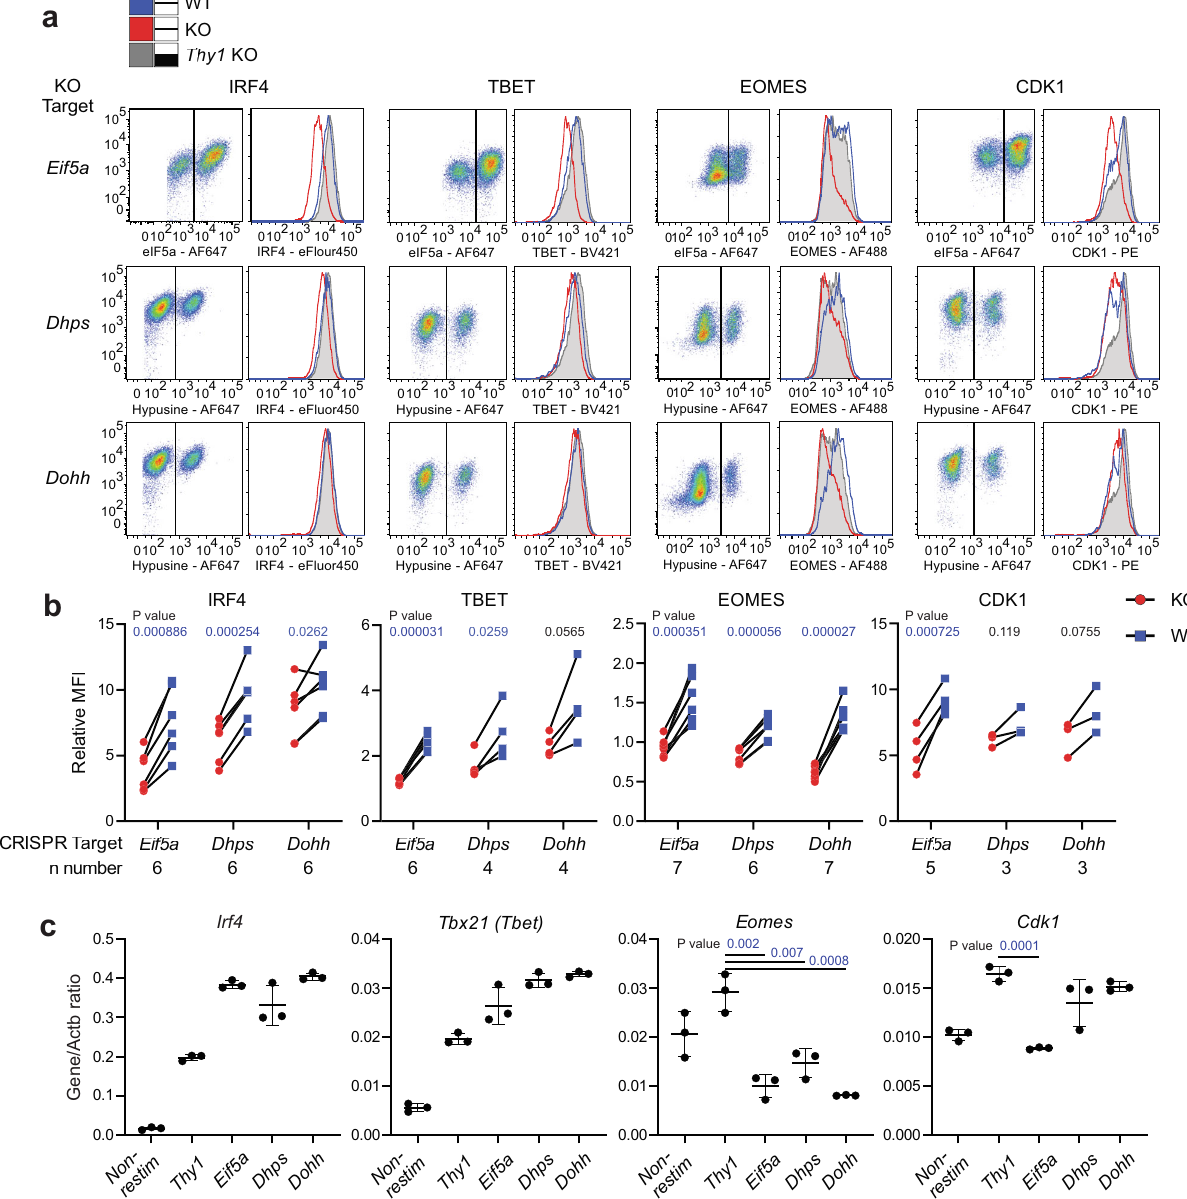
Fig. 6 | Flow cytometry and qRT-PCR validation of eIF5a-regulated proteins. a Intracellularstains for eIF5a or hypusine wereusedto identify WT (blue line) and KO(redline) populationsin Eif5a , Dhps ,or Dohh CRISPR-KOcells(dotplotsonleft show the extent of KO). Thy1 CRISPR cells (grey shaded line) were used as a KO control.OverlayhistogramsonrightshowIRF4,TBET,EOMESandCDK1expression in electronically gated WT and KO samples. b Quanti fi cation of multiple paired